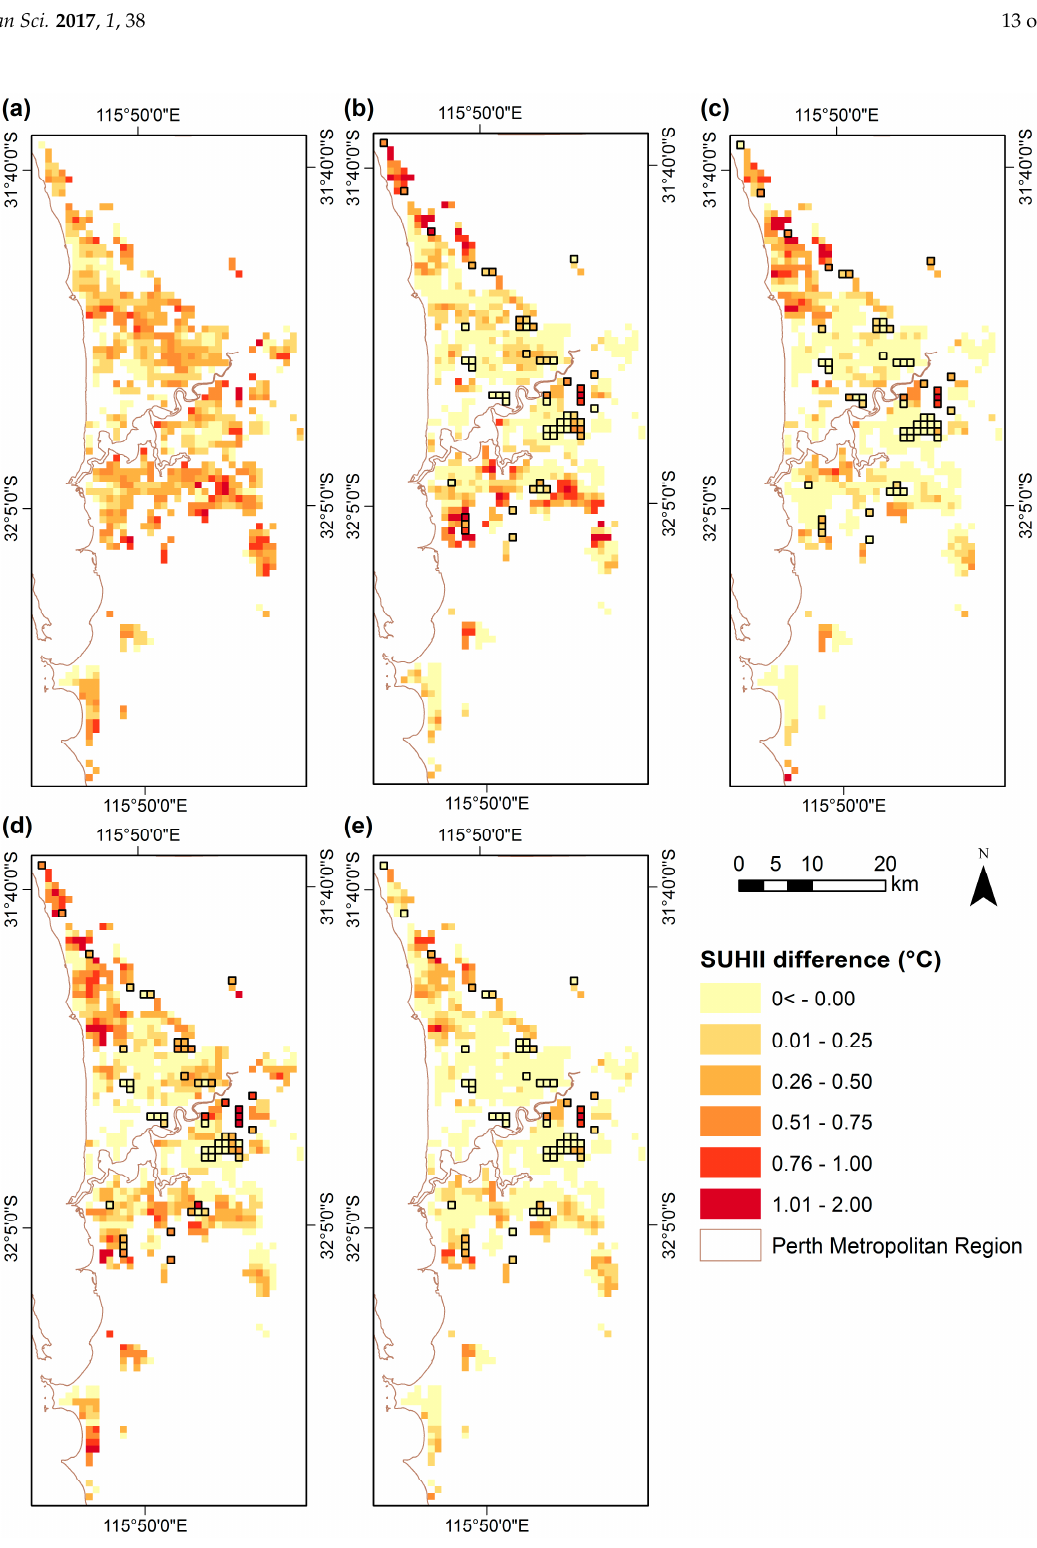
Figure 7. The spatial distribution of the difference in nighttime SUHII for pixels that remained urban between 2013 and 2003 for: ( a ) summer ( b ) autumn ( c ) winter ( d ) spring and ( e ) annual. Urban (low and high albedo) and forest MODIS pixels are identified where a single Landsat land cover class composed >50% of a MODIS pixel. Black outlined MODIS pixels represent high urban albedo.